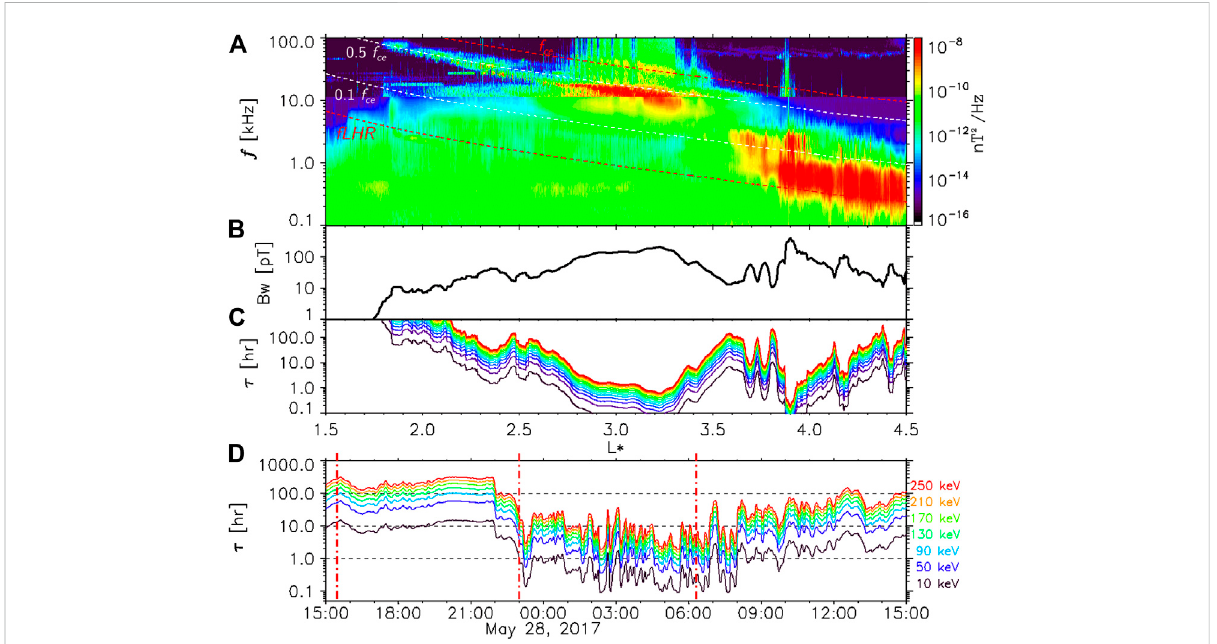
FIGURE 4 (A) Dynamic spectrum of chorus wave magnetic fi eld from Van Allen Probe B, obtained from EMFISIS on 2017-05-28 (08:00-09:30UT) below 10 kHz and HFR (electric fi eld was recalculated into magnetic fi eld magnitude under the approximation of fi eld aligned propagation) above 10 kHz. (B) Choruswavesamplitude,B w (pT). (C) Timescaleforelectron(10-1,000 keV)quasi-linearscatteringbylowerbandchoruswaves, τ = 1/ D aa . (D) The 10-250 keV electron lifetime ( τ ) dynamics at L* = 2.5 during the time interval from Figure 2 (electron energies are color coded). Electron cyclotron frequency f ce and lower hybrid frequency fLHR are indicated by the red curves, 0.5 f ce and 0.1 f ce are indicated by the white curves. The vertical dashed red lines refer to the onset time of the geomagnetic storm ’ s